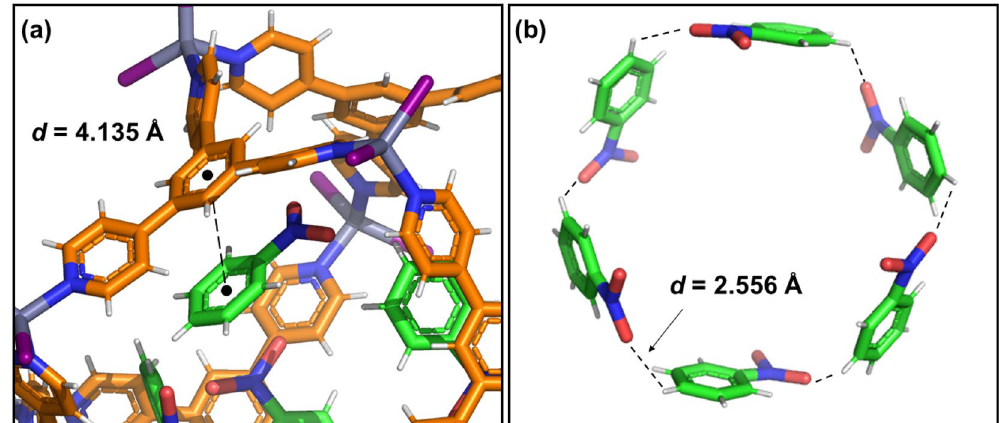
Figure 5. Crystal structure of poly-[ n ]-catenane ( 1 ) showing the host–guest interactions among the benzene ring of TPB and the benzene ring of nitrobenzene. Benzene-host ···benzene-guest is depicted by the black dashed line ( a ). Guest-guest interactions within the M 12 L 8 nanocages shown as dashed lines ( b ). Color code as in Fig. 3.